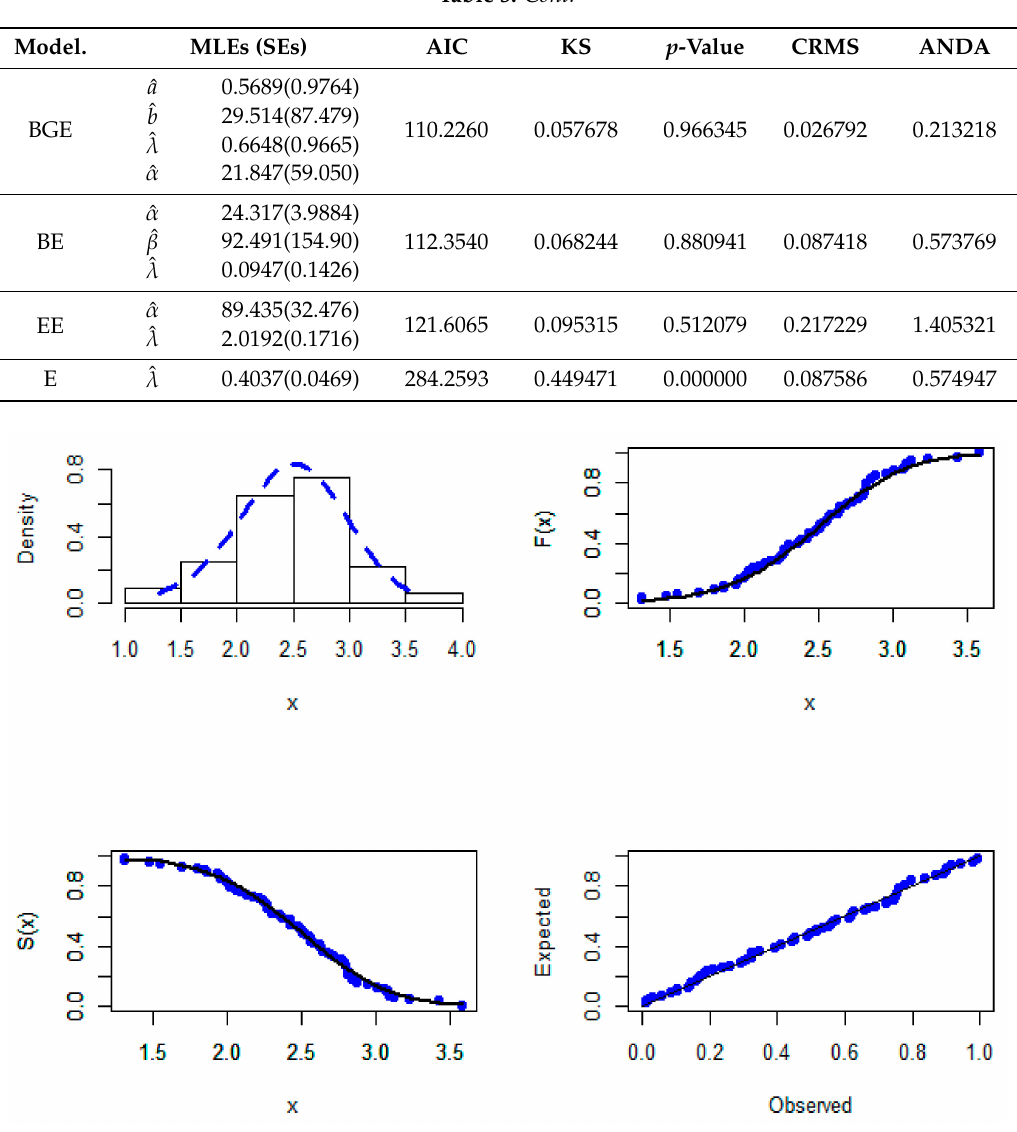
Figure 3. Fitted PDF, cumulative distribution function (CDF), survival function (SF) and probability– probability (PP) plots of the OEHLE model for gauge lengths